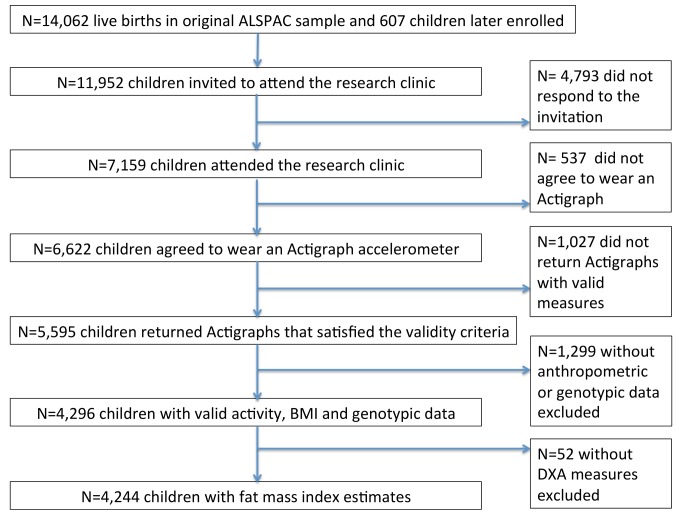
Participants in ALSPAC and in the analyses presented in this paper.DXA, dual energy X-ray absorptiometry.